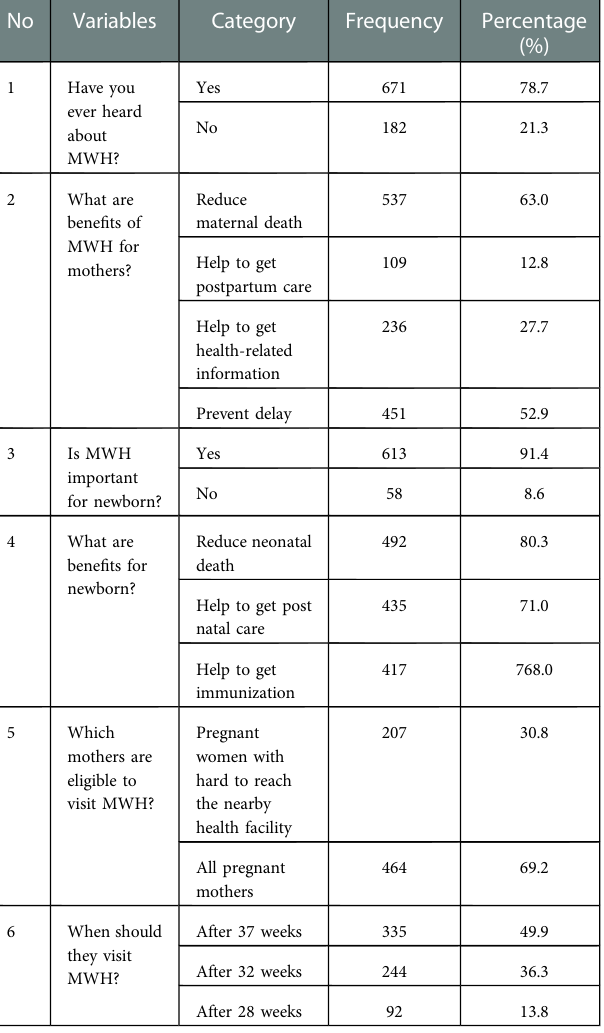
TABLE 3 Knowledge of women regarding MWH services in Dega Damot district, northwest Ethiopia, 2021 ( n =853). No